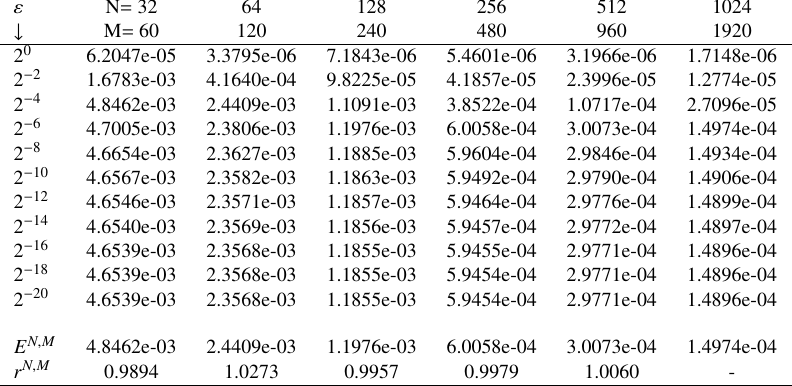
Table 2. Example 4.1, maximum absolute errors of the proposed scheme for δ = 0 . 6 ε and η = 0 . 5 ε . ε